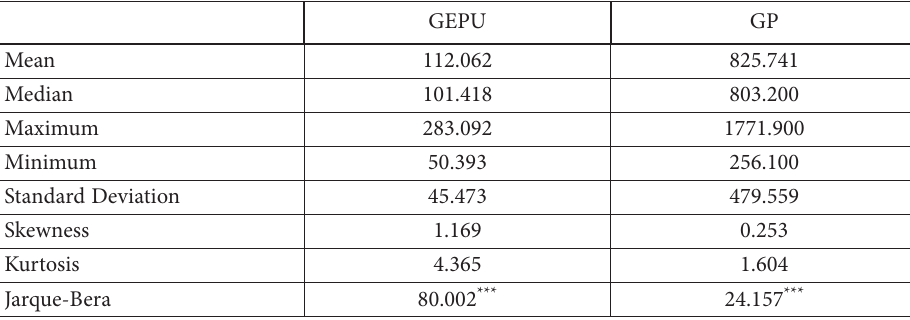
Table 1. Descriptive statistics for GEPU and GP